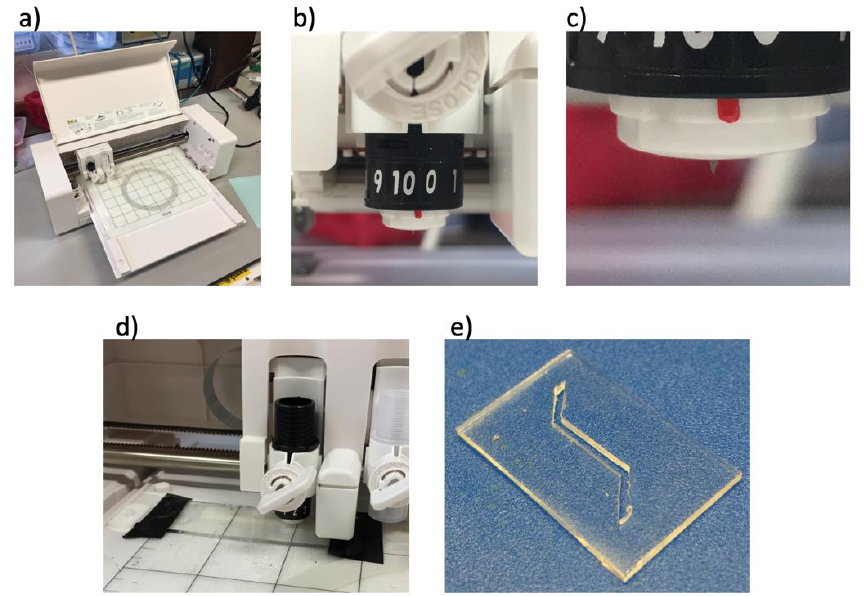
Figure 5. Low cost desktop cutter. ( a ) The desktop Silhouette Curio ™ : ( b ) Tunable tungsten alloy blade used to make incisions. ( c ) Sintered tungsten alloy blade set to 1000 µ m cut depth. ( d ) Silhouette Curio ™ cutting into a 500 µ m sheet of PDMS. ( e ) A PDMS microfluidic channel successfully cut using the Silhouette Curio ™ . Height and width of the channel were set to 500 µ